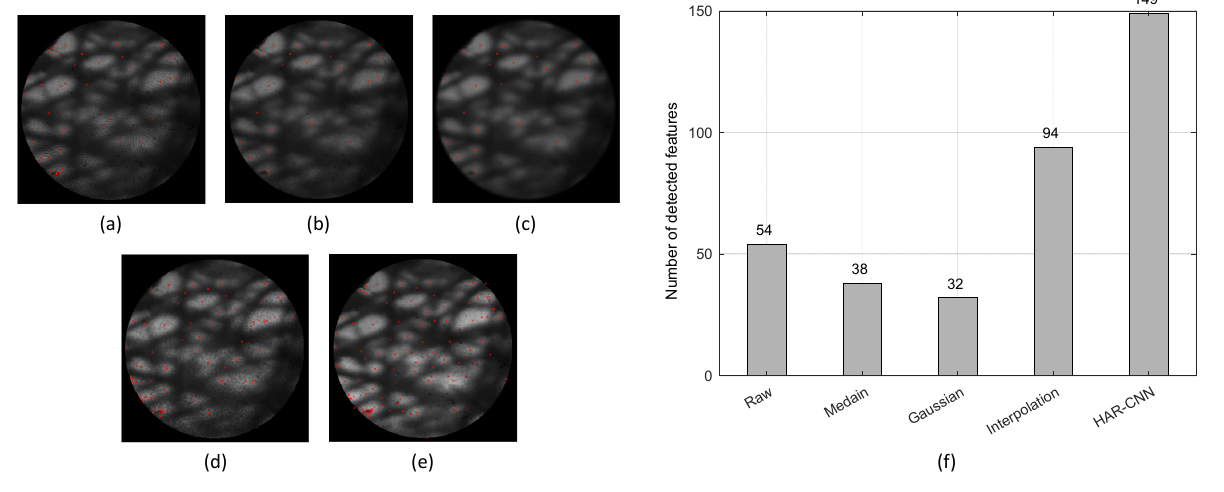
Figure 8. Detected image feature points for various honeycomb removal methods on the lens tissue sample: ( a ) raw fiber bundle image, ( b ) median filter, ( c ) Gaussian filter, ( d ) interpolation, and ( e ) HAR-CNN. The red cross indicates a detected image feature point. ( f ) The number of detected image features for the various honeycomb removal